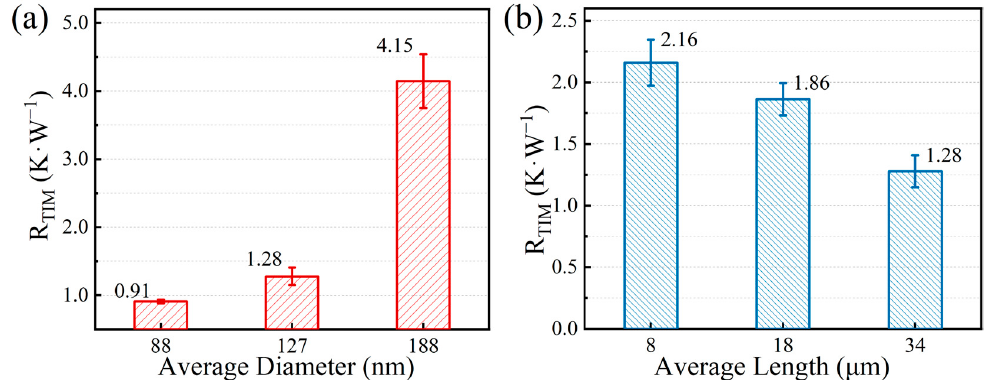
Figure 9. Thermal resistance of sintered silver nanowire film prepared with different sizes of the silver nanowire. ( a ) Silver nanowire films prepared with silver nanowires (1), (2), and (3) in Figure 1. ( b ) Silver nanowire films prepared with silver nanowires (4), (5), and (2) in Figure 1.